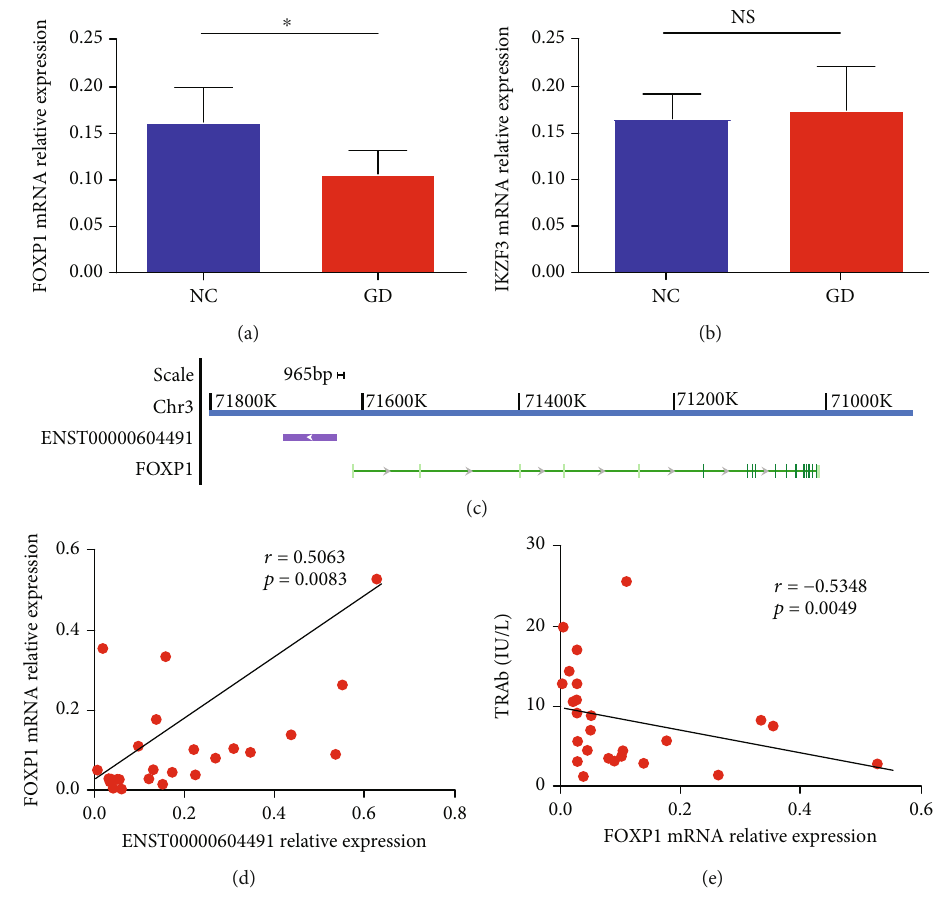
Figure 7: Correlation between ENST00000604491 and FOXP1. (a) The relative expression of FOXP1 mRNA in PBMCs between GD and NC. (b) qRT-PCR analysis of the transcript levels of IKZF3 in PBMCs from GD patients and controls. (c) Relative genomic positions of ENST00000604491 and FOXP1 on human chromosome 3. (d) The correlation between ENST00000604491 levels and FOXP1 levels in patients with GD. (e) The correlation between the transcript levels of ENST00000604491 and the serum levels of TRAb in GD. Each data point represents an individual subject. ∗ p < 0 : 05